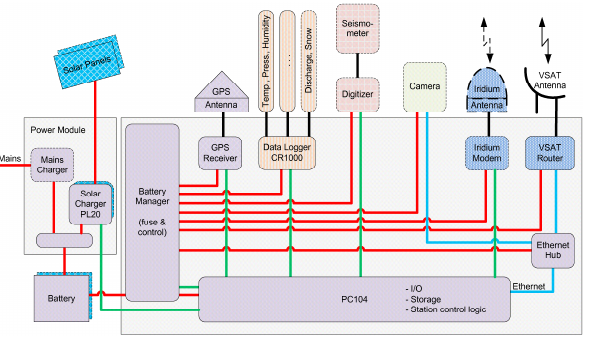
Fig. 3: Schematic ROMPS concept: (red lines) power lines, (green lines) RS232 connections, 6 Fig. 3. Schematic ROMPS concept: (red lines) power lines, (green (blue lines) Ethernet connectors. The Power Module (left) provides 12 V power and power 7 lines) RS232 connections, (blue lines) Ethernet connectors. The state information. All hardware is connected to and managed by the PC module (PC104 & 8 power module (left) provides 12V power and power state informa- Battery manager) and dedicated software. 9 tion. All hardware is connected to and managed by the PC module (PC104&Battery manager) and dedicated